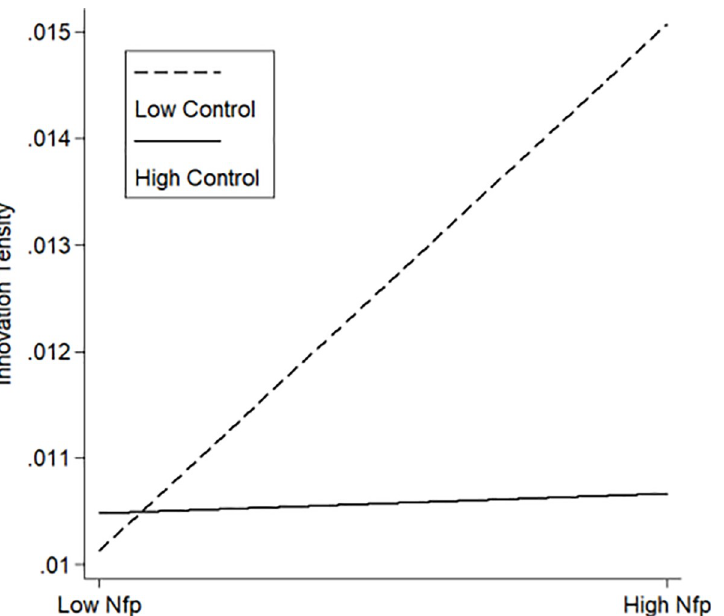
Fig 2. The moderating effect of the family control and